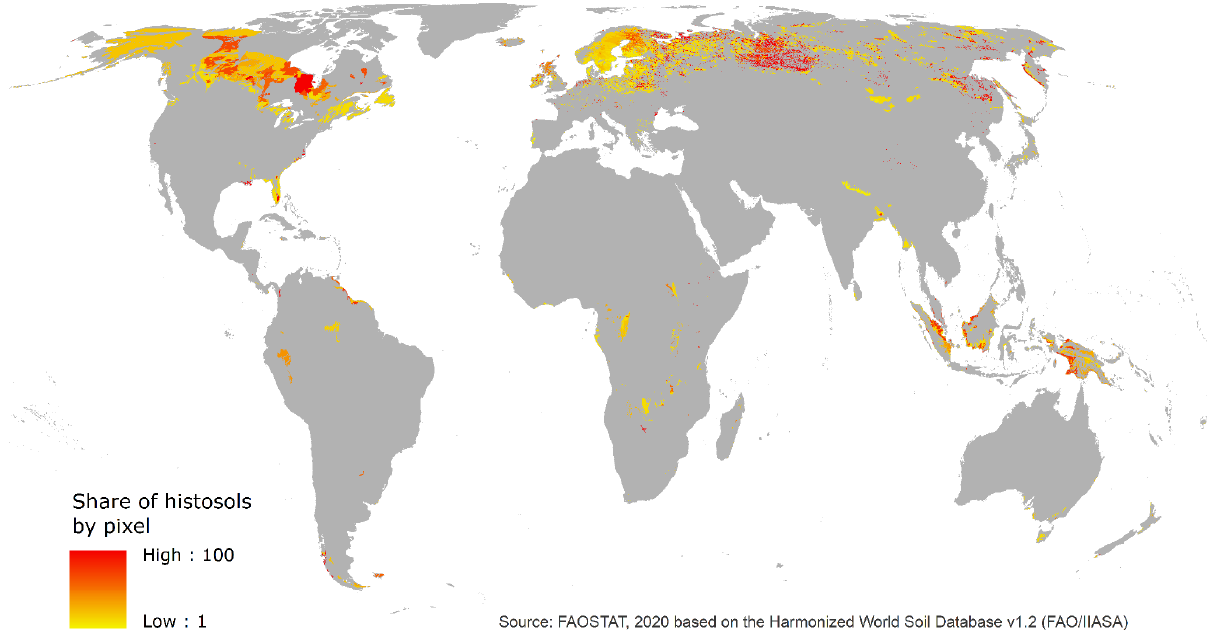
Figure 1. Global distribution of histosols shown by percentage of pixel area. Table 2. Proportion of area of relevant CCI-LC pixels corresponding to land cover